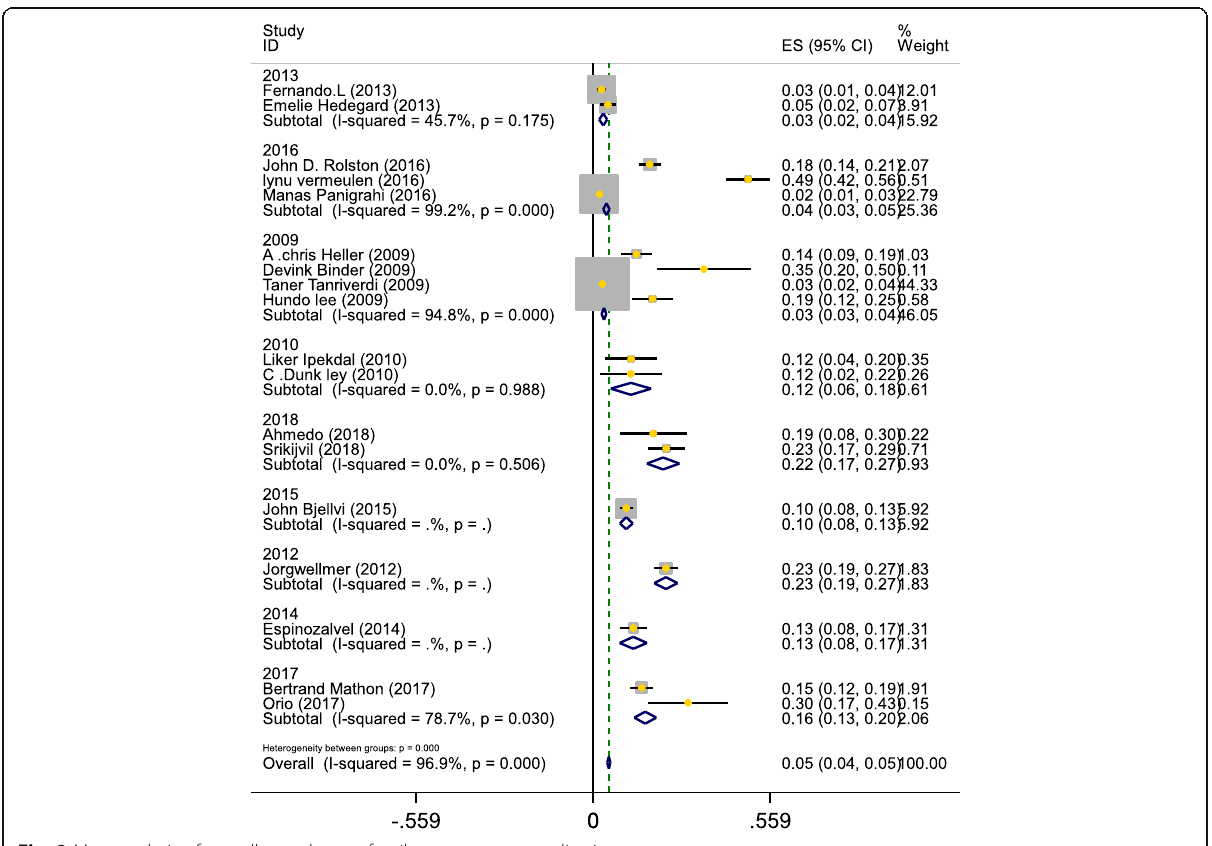
Fig. 2 Meta-analysis of overall prevalence of epilepsy surgery